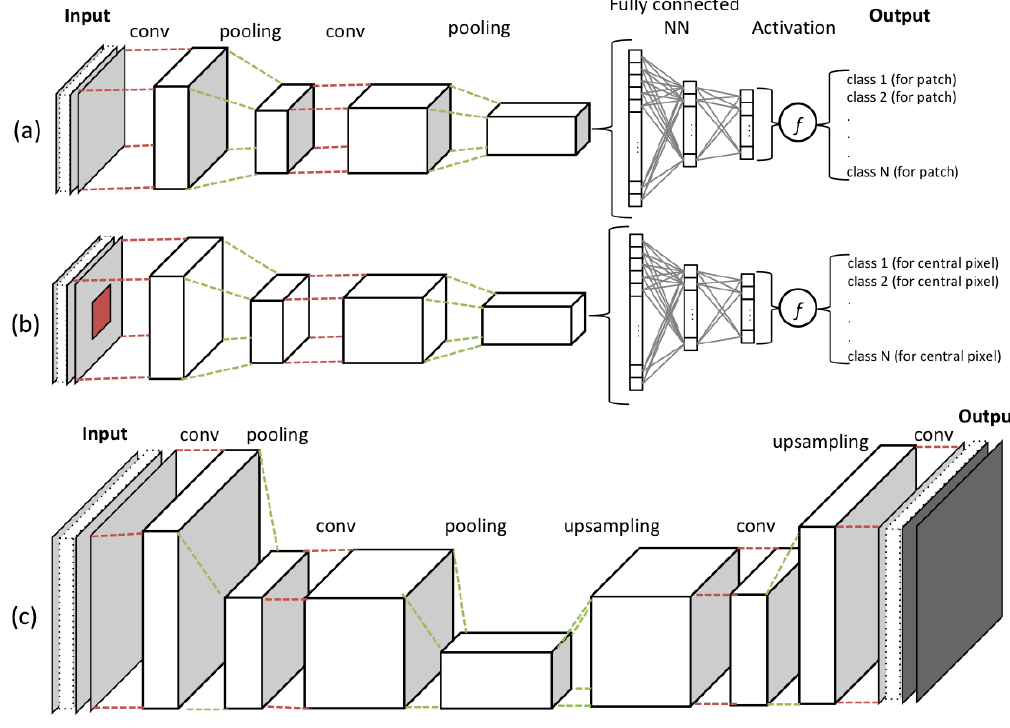
Figure 6. An example of convolutional neural network with two layers of convolution and two layers of pooling, for ( a ) patch level classification, ( b ) pixel level classification and ( c ) an image reconstructive model. The resulting cubes after each layer of convolution and pooling are called feature maps.